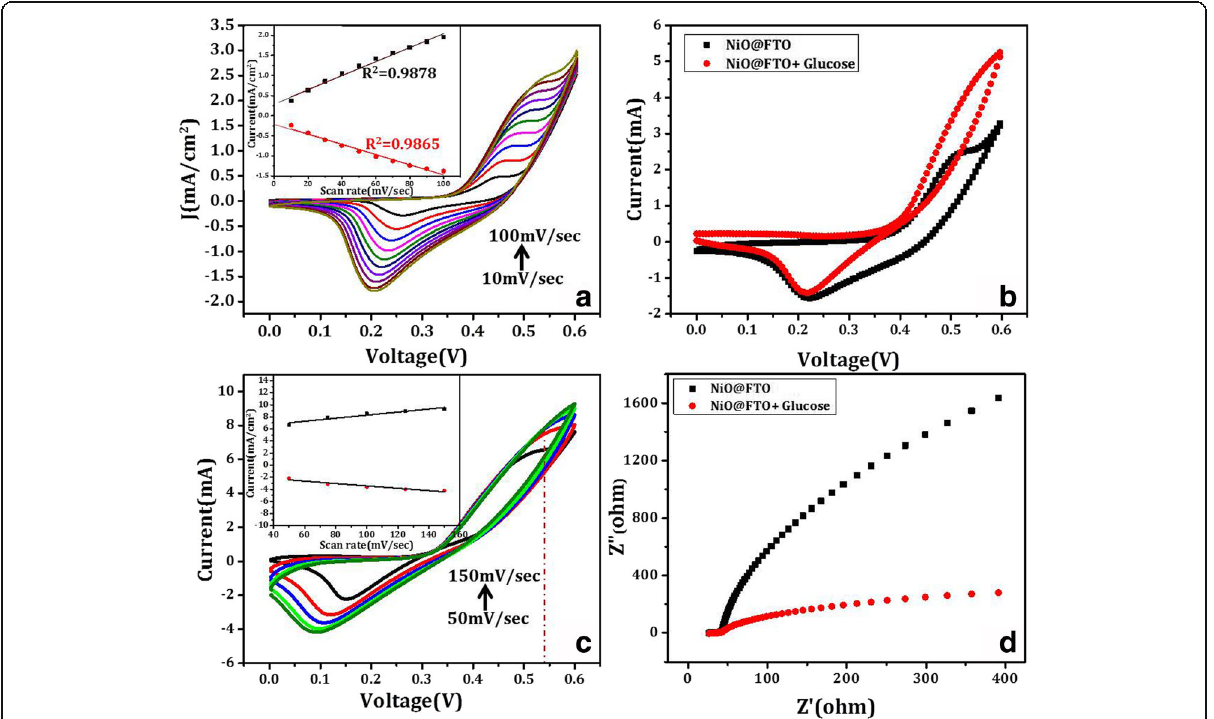
Fig. 3 a Cyclic voltammetry (CV) of NiO-NPs@FTO on various scan rates. b Elctrochemical glucose(10 μ M) sensing using CV technique. c CV scan of glucose immobilized NiO-NPs@FTO electrode at various scan rates. b Electrochemical impedance spectroscopy (EIS) to show glucose sensing. Insets in a and c show a linear variation of current as a function of scan